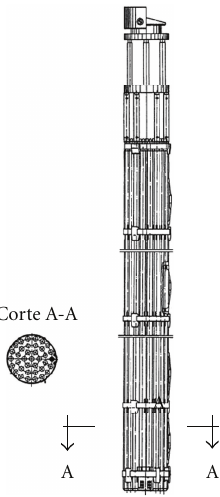
Figure 2: Atucha I fuel